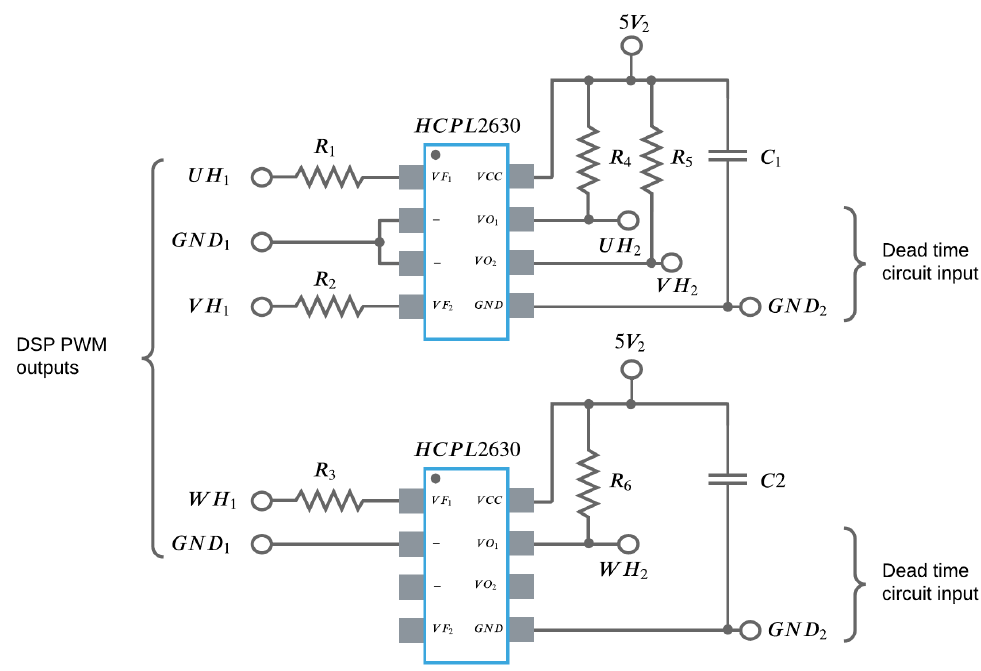
Figure 5. PWM signal isolation circuit [30].